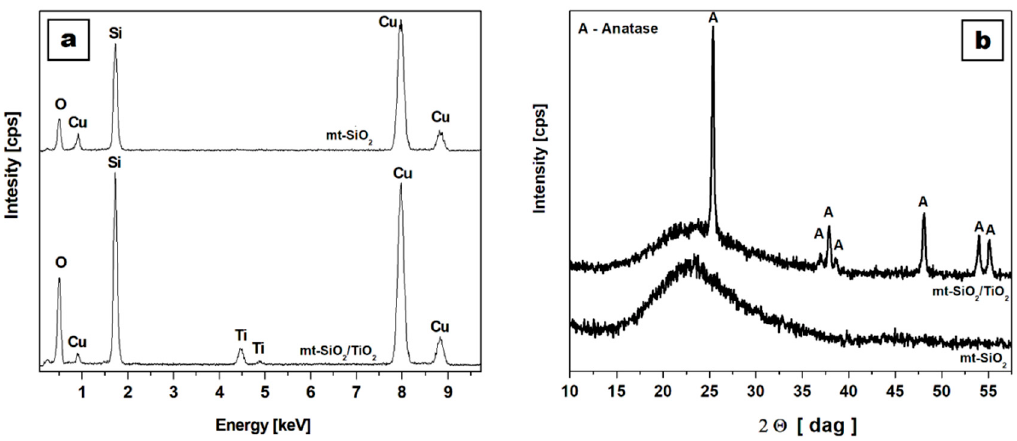
Figure 2. Energy-dispersive X-ray spectra ( a ) and X-ray diffraction pattern ( b ) of pristine (mt-SiO 2 ) and titanium dioxide (mt-SiO 2 / TiO 2 ) functionalized mesoporous silica nanotubes.